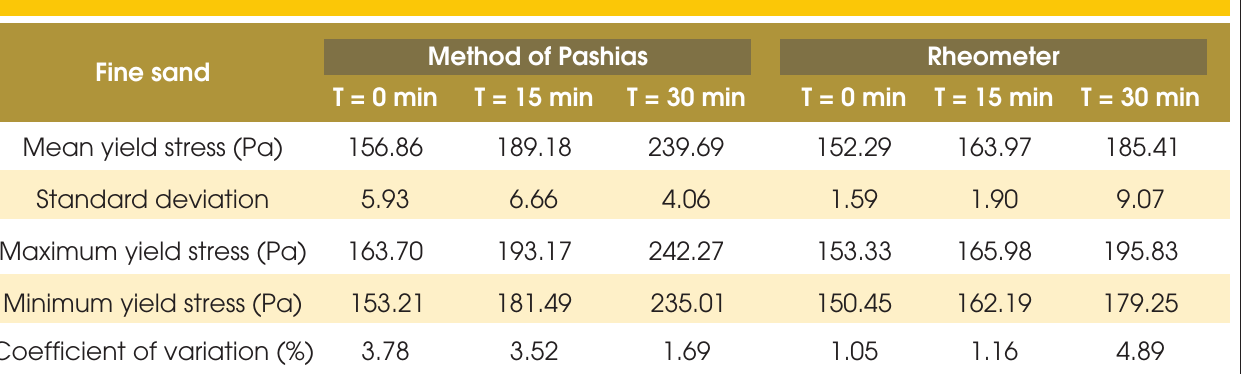
Table 14 – Statistical analysis of the results for mortars with w/c = 0.50 and fine